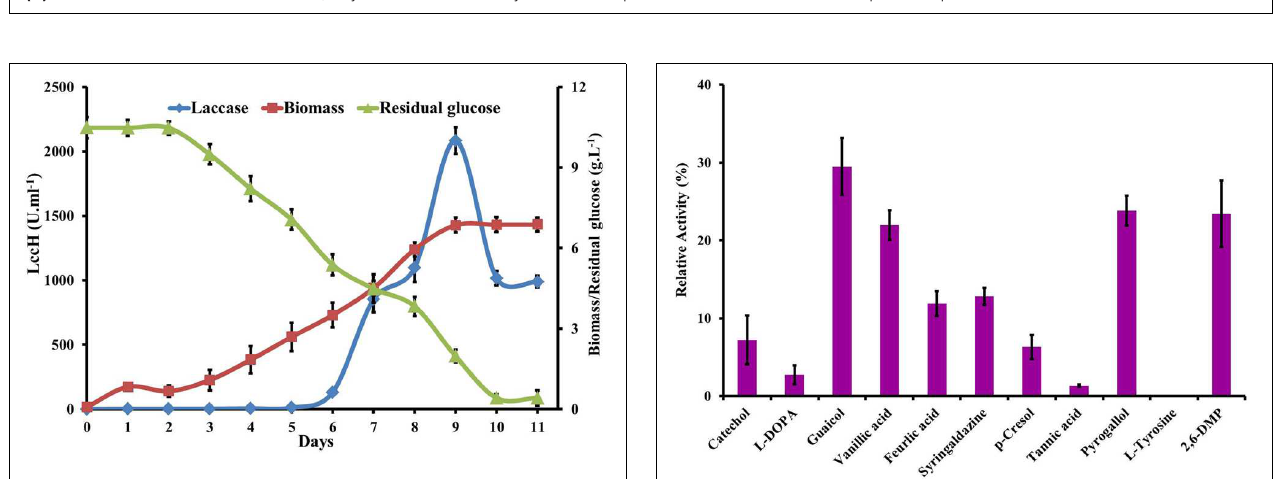
FIGURE 4 | Optimization of media and inducers for LccH production. (A) The H. hirta MSF2 was grown in different media viz ., PDB, GY, SYE, GKP, and GP at 30 ◦ C under static conditions and culture supernatants were assayed for LccH activity at standard assay conditions. (B) Optimization of CuSO4 concentrations for LccH production on GY medium. (C) Effect of inducers on LccH activity. All the inducers were evaluated at 1 mM concentration along with 500 µ m of CuSO4. (D) Effect of different concentration of 2,5 Xylidine on LccH activity. Error bars represent standard deviations of triplicate experiments.